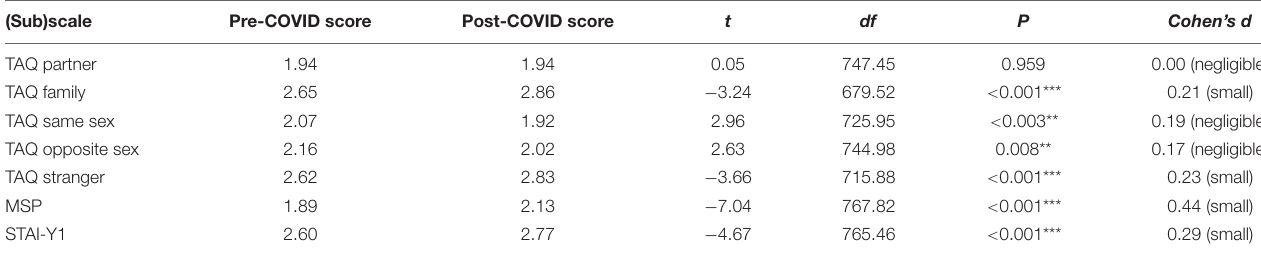
TABLE 3 | Pre-post comparisons for the scores on each subscale.